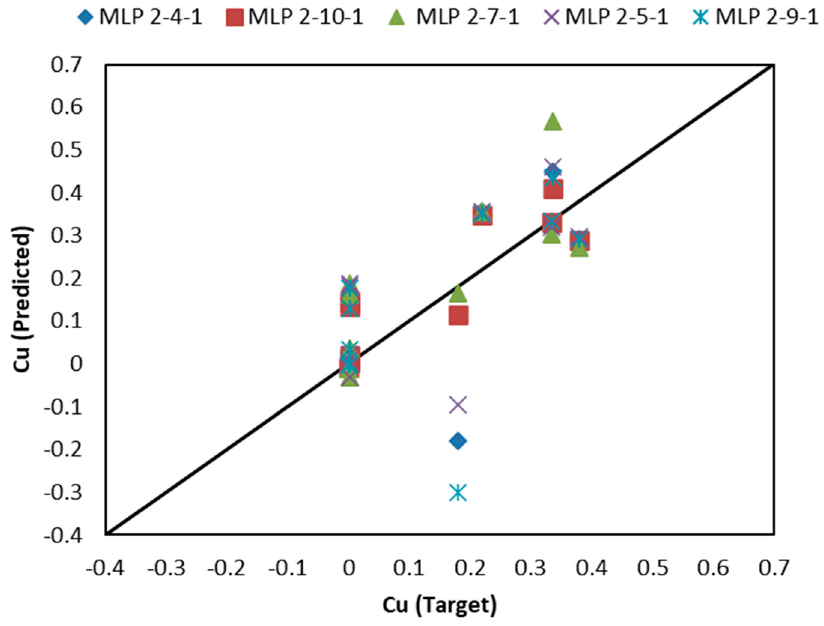
Table 3. Correlation coefficient and RMSE values for different MLP topologies in all stages for Cu .